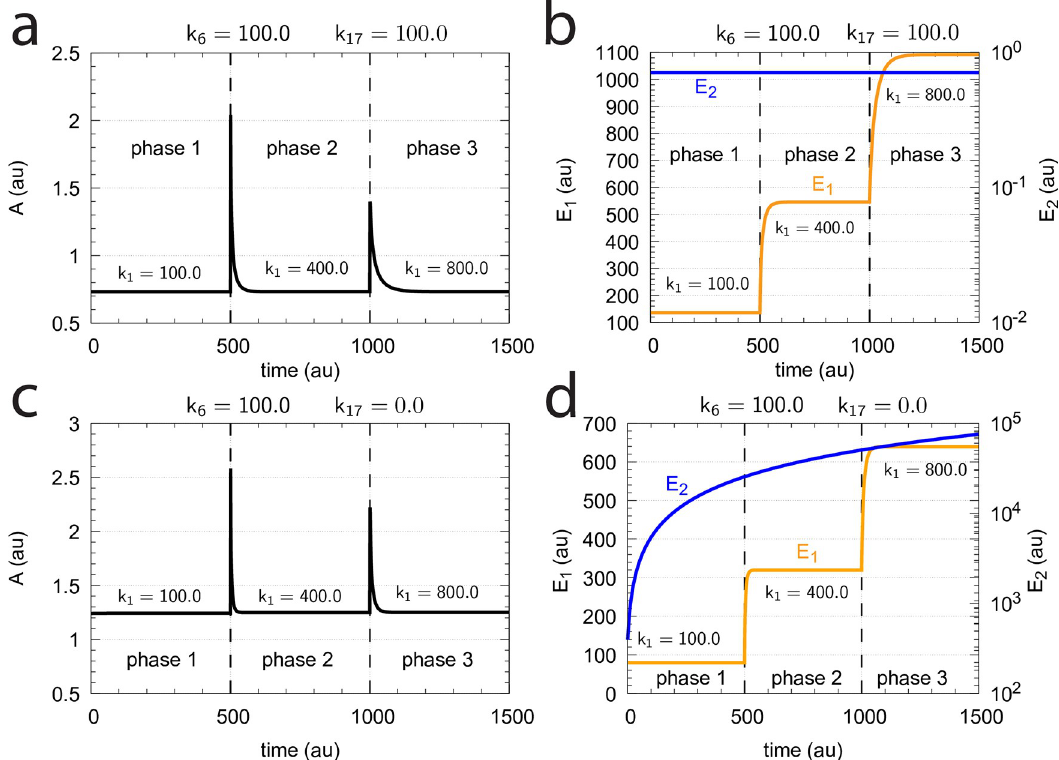
Fig 47. Demonstration of the homeostatic behavior of A ss in Fig 45 when k 6 =100.0 and k 17 =100.0 (panels a and b) or k 17 =0.0 (panel c and d). Step-wise perturbations are applied with values k 1 =100 (phase 1), k 1 =400 (phase 2), and k 1 =800 (phase 3). Other rate constants as in Fig 45. The linear increase of E 2 is seen as a concave line due to the logarithmic scale of the E 2 -axis. Initial concentrations, (a) and (b): A 0 =0.7309, E 1,0 =1.36 × 10 2 , E 2,0 =7.08 × 10 − 1 , Ez 0 =2.15 × 10 − 9 , (E 1 � Ez) 0 =2.95 × 10 − 7 , (Ez � � E 2 ) 0 =2.93 × 10 − 7 , and Ez � =4.13 × 10 − 7 . Initial concentrations, (c) and (d): A 0 =1.24, E 1,0 =7.96 × 10 1 , E 2,0 =3.50 × 10 − 2 , 0 Ez 0 =6.23 × 10 − 9 , (E 1 � Ez) 0 =4.96 × 10 − 7 , (Ez � � E 2 ) 0 =4.96 × 10 − 7 , and Ez � =1.41 × 10 − 9 . 0